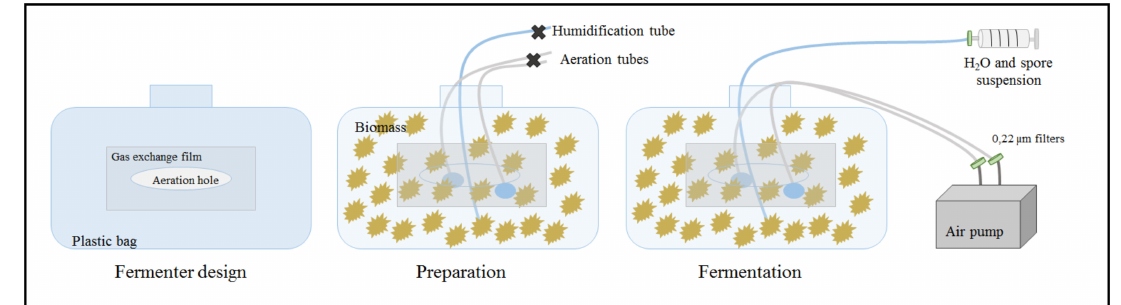
Figure 5. Illustration of aerated plastic bag fermenter (at left), made from autoclavable biohazard bags in polypropylene with an aeration hole covered by a gas exchange Miracloth film (Millipore, USA). Prior to autoclaving (middle), corn cobs were introduced as well as the air and humidification tubes (autoclavable tubes in PVC used for the liquid bioreactor). Right: Operative fermenter with aeration and the inoculum to be injected.